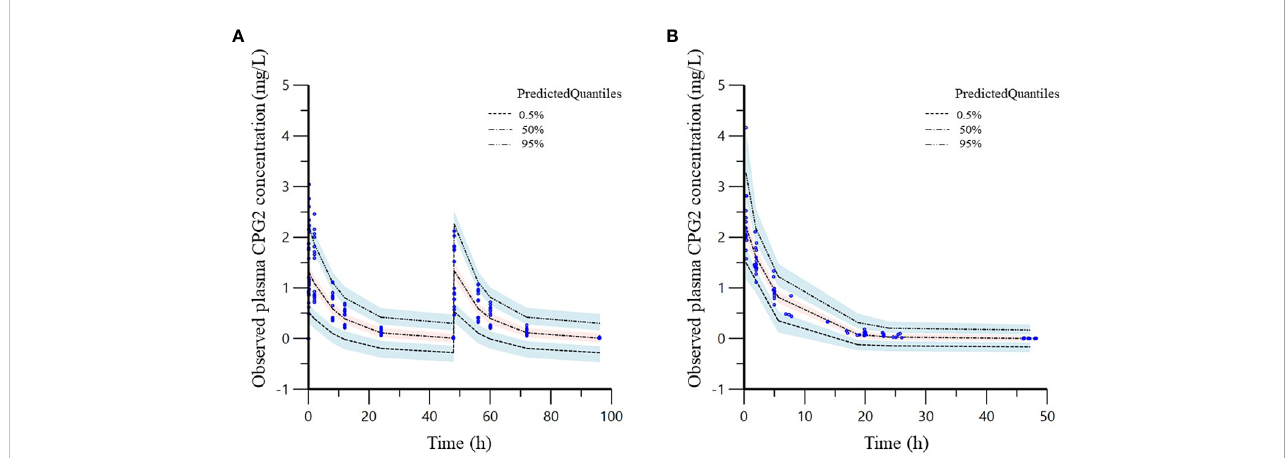
FIGURE 5 Visual predictive check (VPC) of the phase 1 (A) and 2 (B) study CPG2 fi nal model. Quantile deviation (blue shaded) obtained from 1,000 datasets using the fi nal model was superimposed on the observed plasma CPG2 concentration of quantile deviation (red shaded). Blue shaded is 95% con fi dence intervals for the predicted 5th and 95th percentiles. Red shaded is 95% con fi dence interval for the predicted 50th percentile. The blue cycles show the observed plasma CPG2 concentrations versus time after CPG2 dosing.